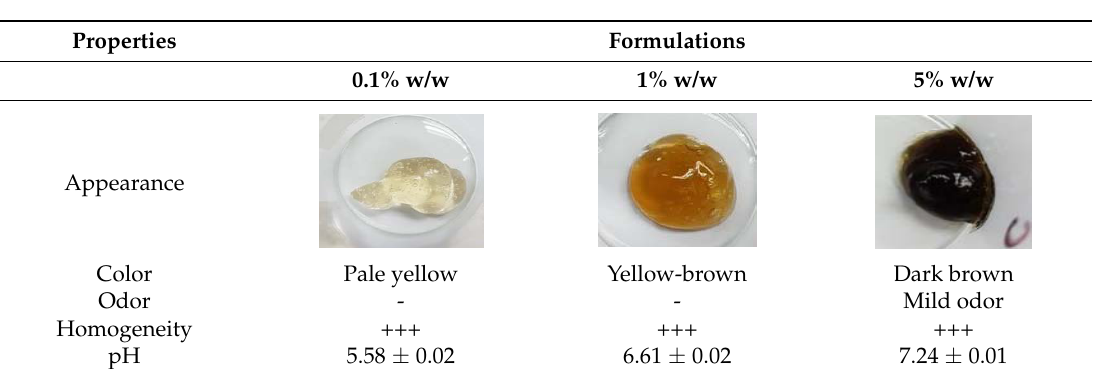
Note: homogeneity was graded as +++ good, ++ fair and + poor.